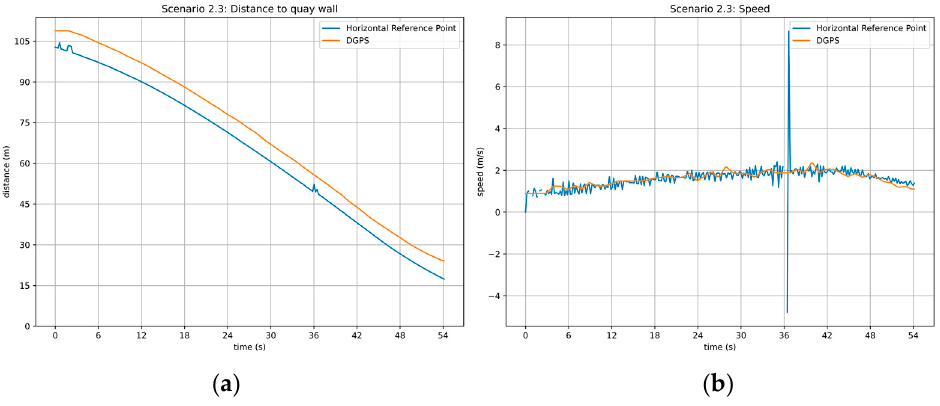
Figure 19. Horizontal distance to meter mark 0 m ( a ) and forward speed for scenario 2.3 ( b ). We observed that the deviation in distance between the DGPS sensor and the hor- izontal Reference Point is relatively constant between 5 and 8 m apart (cf. Figure